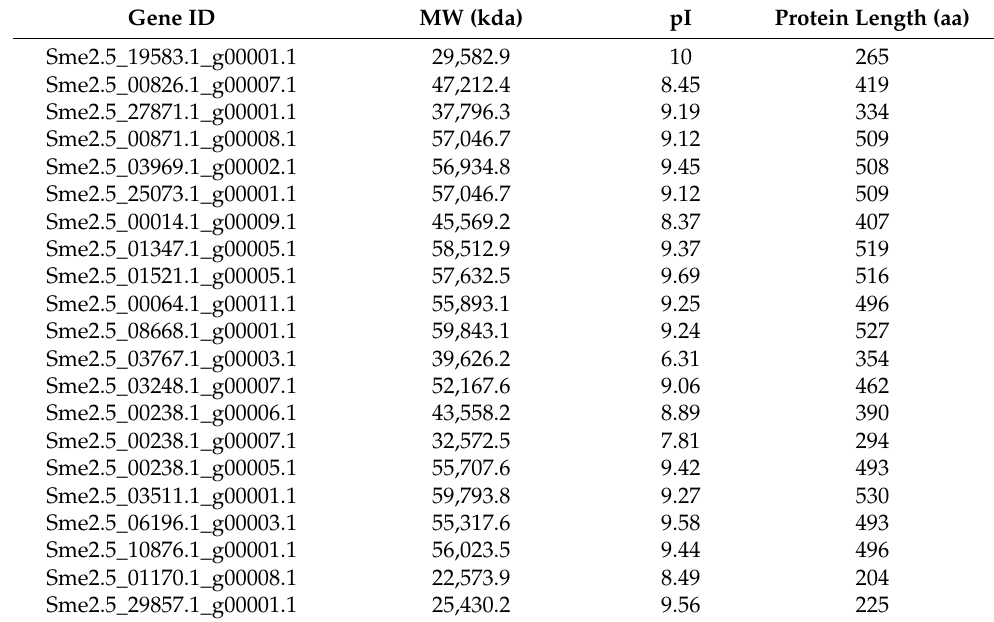
Table 4. The SmKCS proteins in eggplant.